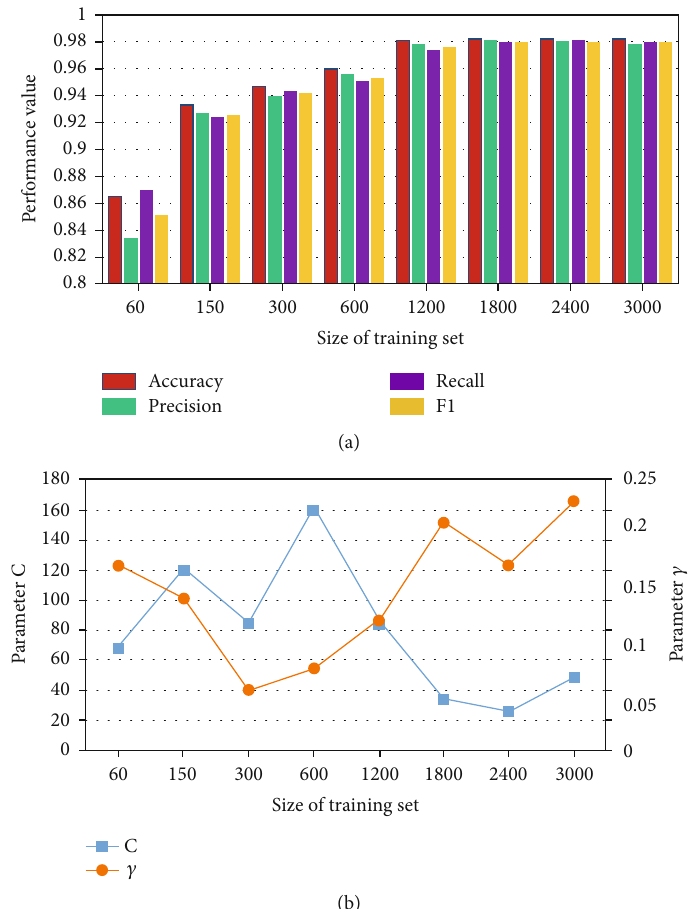
Figure 9: Test set data for SVM. (a) To measure the performance of training samples of di ff erent sizes, the four values are accuracy, precision, recall, and F 1 . (b) Diagram of parameter values, C and γ are represented on the left and right coordinate axes, respectively.